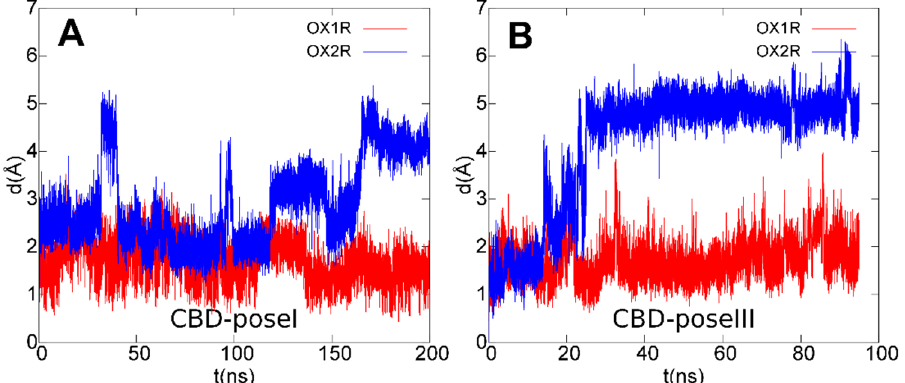
Figure 9. Root mean square deviation (rmsd) plots of CBD ligand in poses I ( A )/III ( B ) during the last 200 ns (A)/95 ns (B) of MD simulations after best-fit of protein backbone in OX1R (red) and OX2R